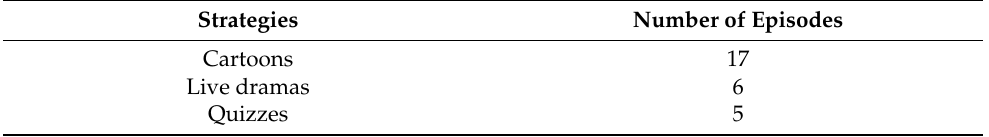
Table 1. Entertainment Strategies Used to Disseminate Health Information Related to